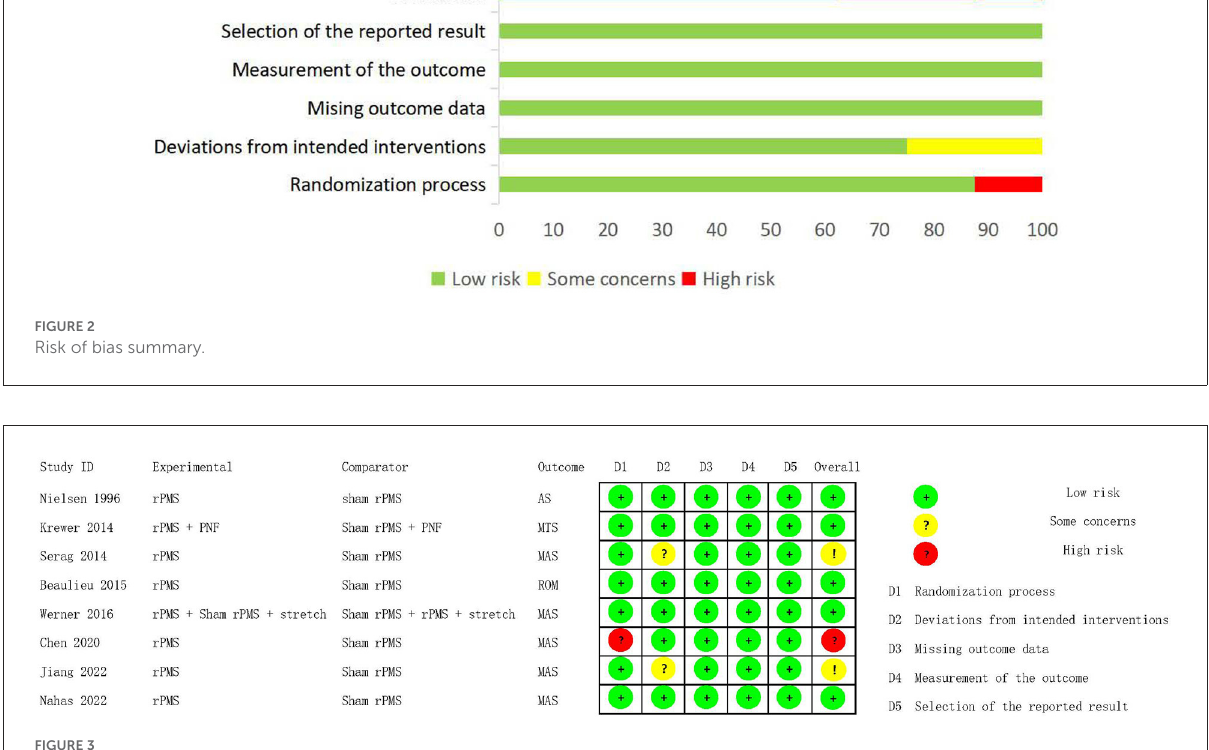
Figure 3. As no difference among the results of risk of bias